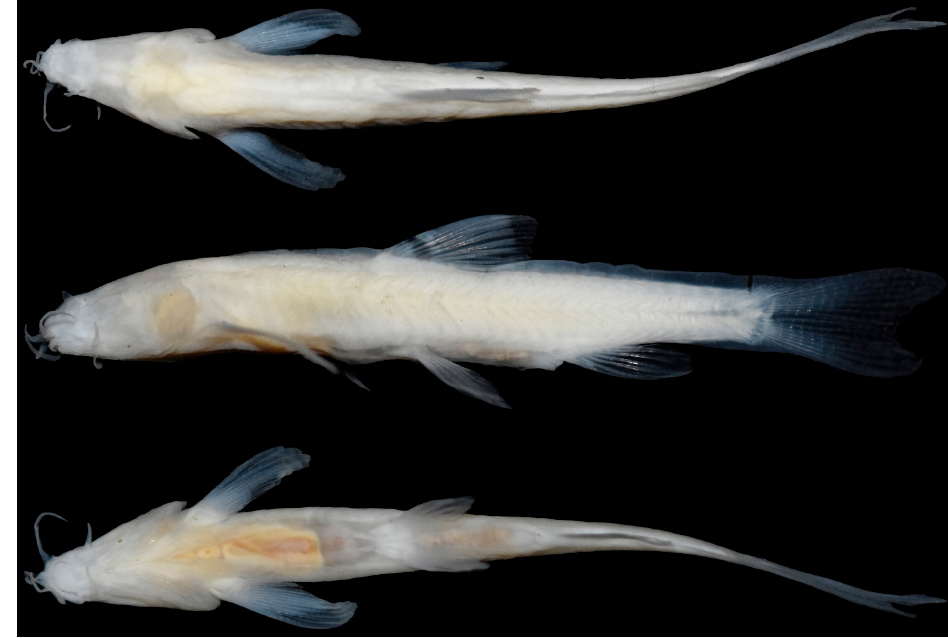
Figure 2. Eidinemacheilus smithi from Tuveh spring SL: 25 mm. Table 2. Morphometric data of E. smithi . ZM-CBSU es-101, n =